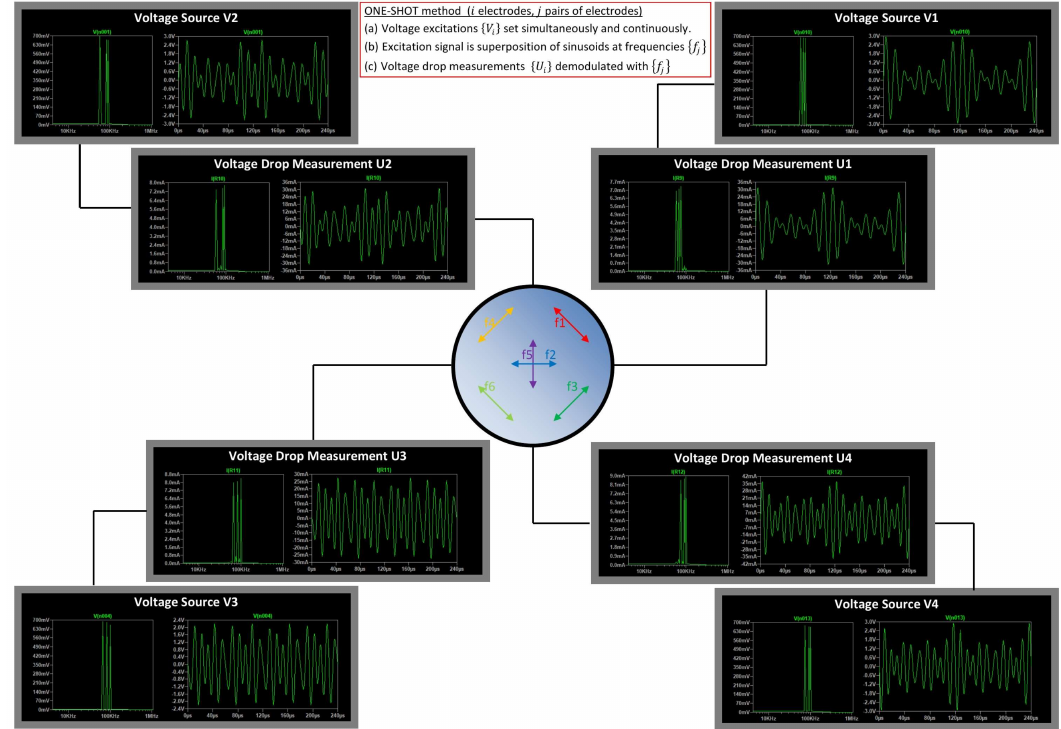
Figure 4. Sketch of the concept of the ONE-SHOT method. Voltage sources generate the excitation signals { V i , i = 1,2,3,4 } as in Equation (8), and electrical currents are deduced from voltage drop measurements { U i , i = 1,2,3,4 } . A set of frequencies of mixed sine waves excitation signals and demodulation of